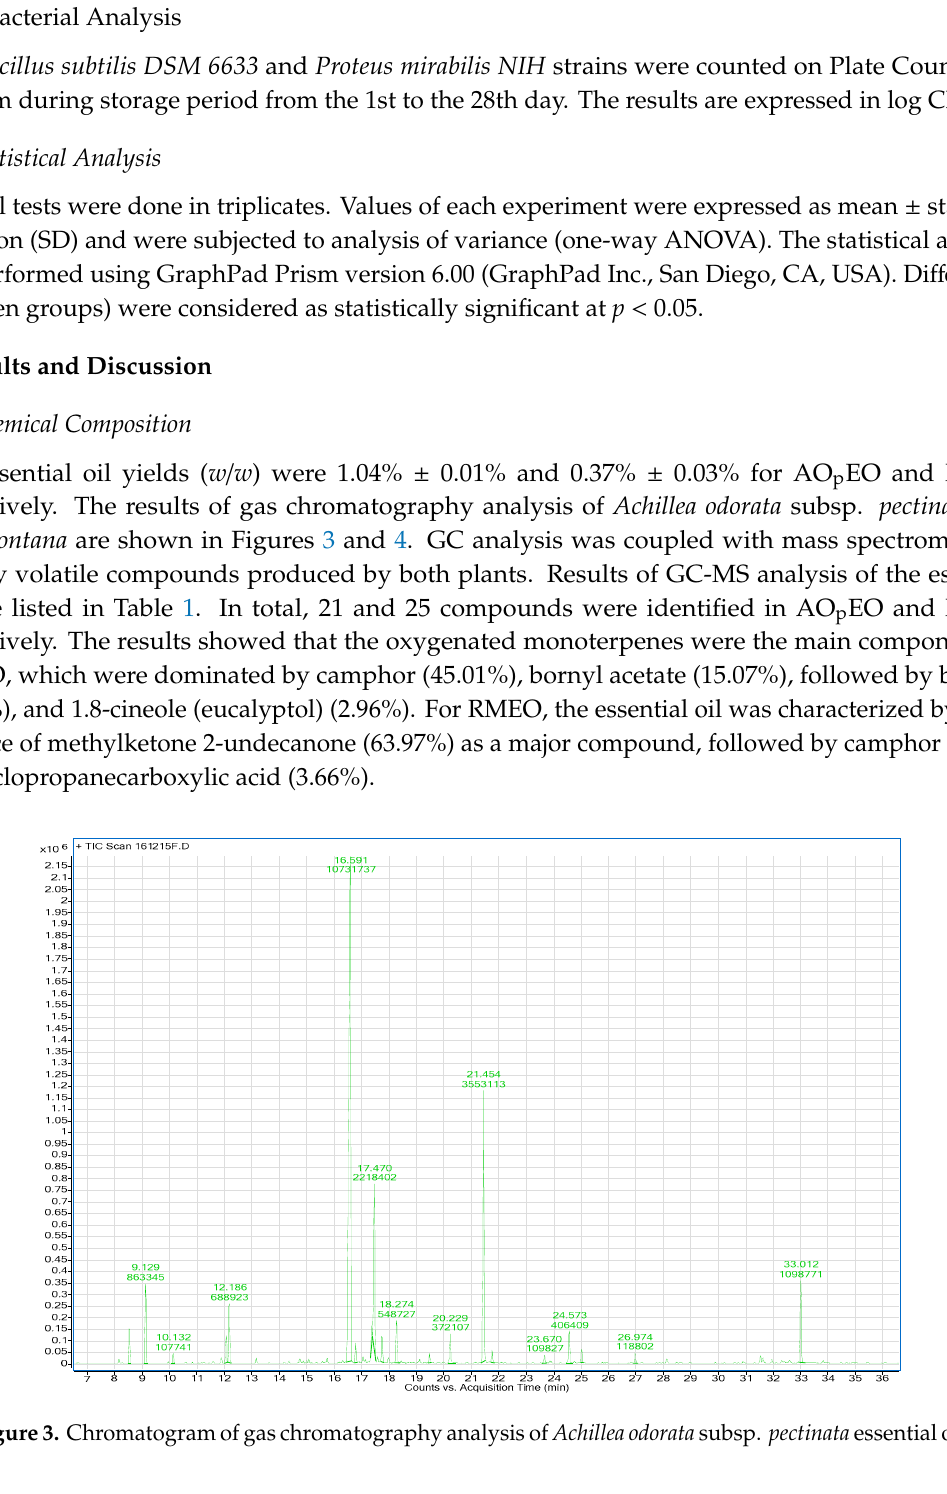
Figure 4. Chromatogram of gas chromatography analysis of Ruta montana essential oil.